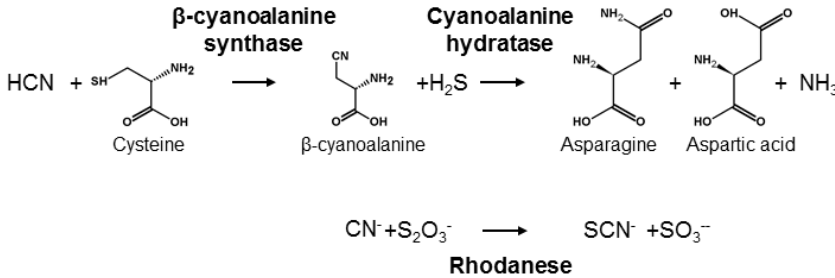
Figure 4. Detoxification of CNglcs.